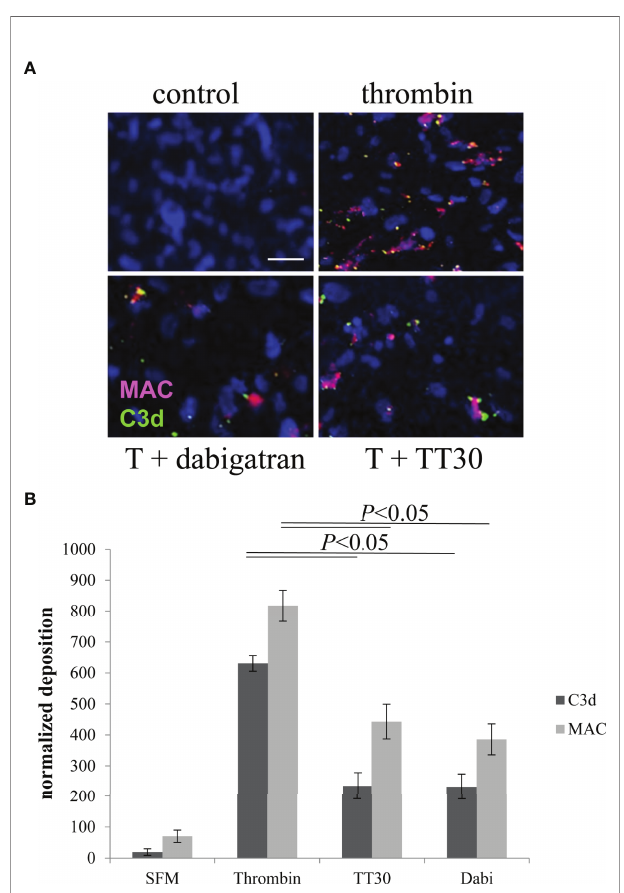
FIGURE 4 | Thrombin-mediated effects on cell-surface activated complement. (A) ARPE-19 cells plated on glass-bottom dishes were assessed for complement activation based on C3d (green) and MAC (red) deposition on the apical surface. Cell bodies were identi fi ed using Hoechst. ARPE cells were either treated with serum-free media (control) or with 20 U/mL of thrombin in the presence and absence of dabigatran (10 m M) or TT30 (10 m M). Please note that ARPE-19 cells secrete complement proteins into the supernatant, suf fi cient to mount a complement attack. (B) C3d and MAC deposits counted by image J were signi fi cantly were identi fi ed in thrombin treated cells and reduced signi fi cantly in cells treated with dabigatran or TT30. Data are plotted as mean ± SEM; n = 3 independent